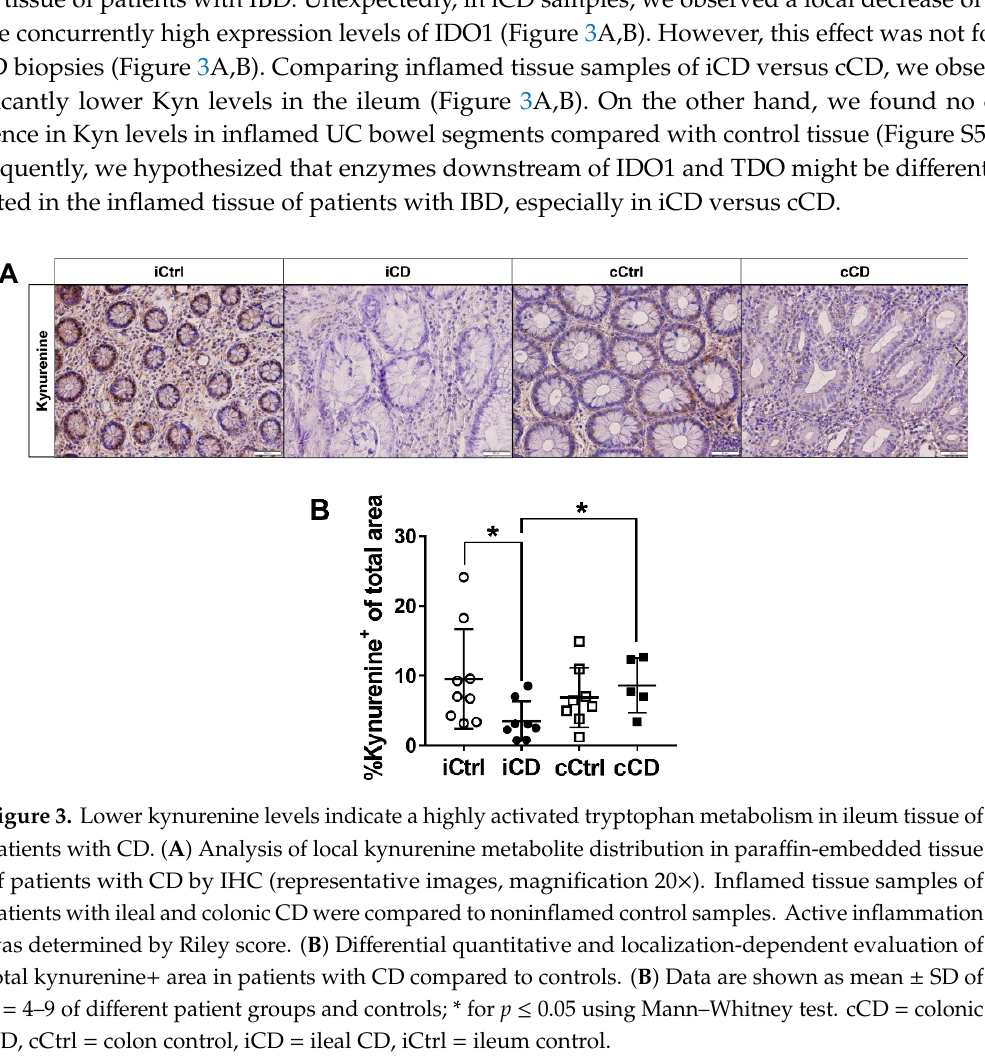
Figure 3. Lower kynurenine levels indicate a highly activated tryptophan metabolism in ileum tissue of patients with CD. ( A ) Analysis of local kynurenine metabolite distribution in paraffin-embedded tissue of patients with CD by IHC (representative images, magnification 20×). Inflamed tissue samples of patients with ileal and colonic CD were compared to noninflamed control samples. Active inflammation was determined by Riley score. ( B ) Differential quantitative and localization-dependent evaluation of total kynurenine+ area in patients with CD compared to controls. ( B ) Data are shown as mean ± SD of n = 4–9 of different patient groups and controls; * for p ≤ 0.05 using Mann–Whitney test. cCD = colonic CD, cCtrl = colon control, iCD = ileal CD, iCtrl = ileum control.